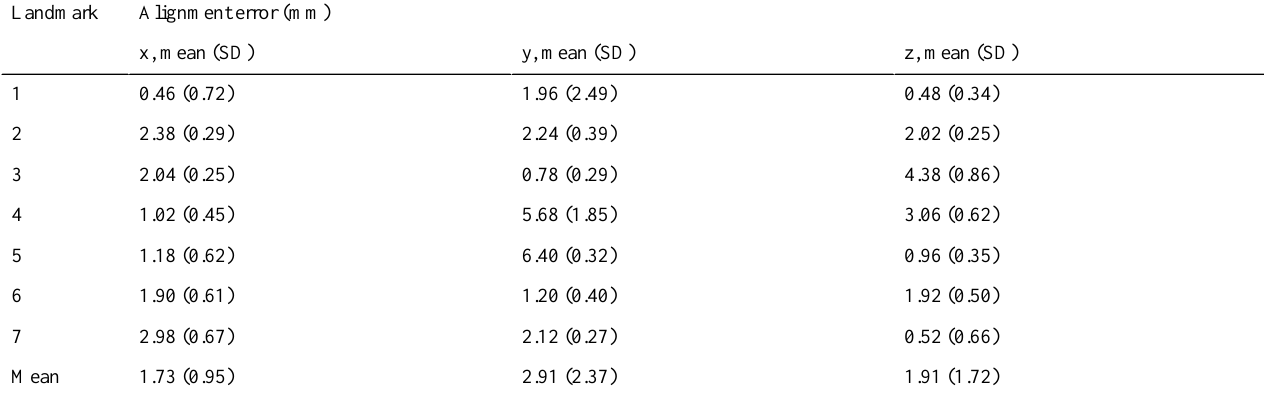
Table 2. Model alignment error. Alignment error